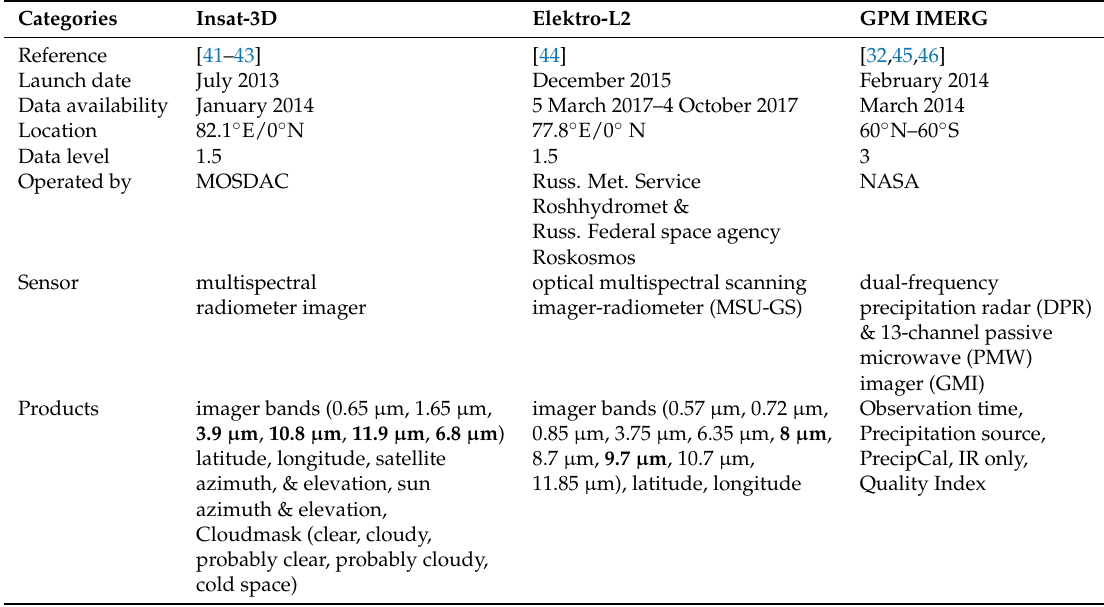
Table 2. Overview of the GEO satellite data and the GPM (Global Precipitation Measurement Mission) IMERG (Integrated Multi-satellitE Retrievals for GPM) precipitation